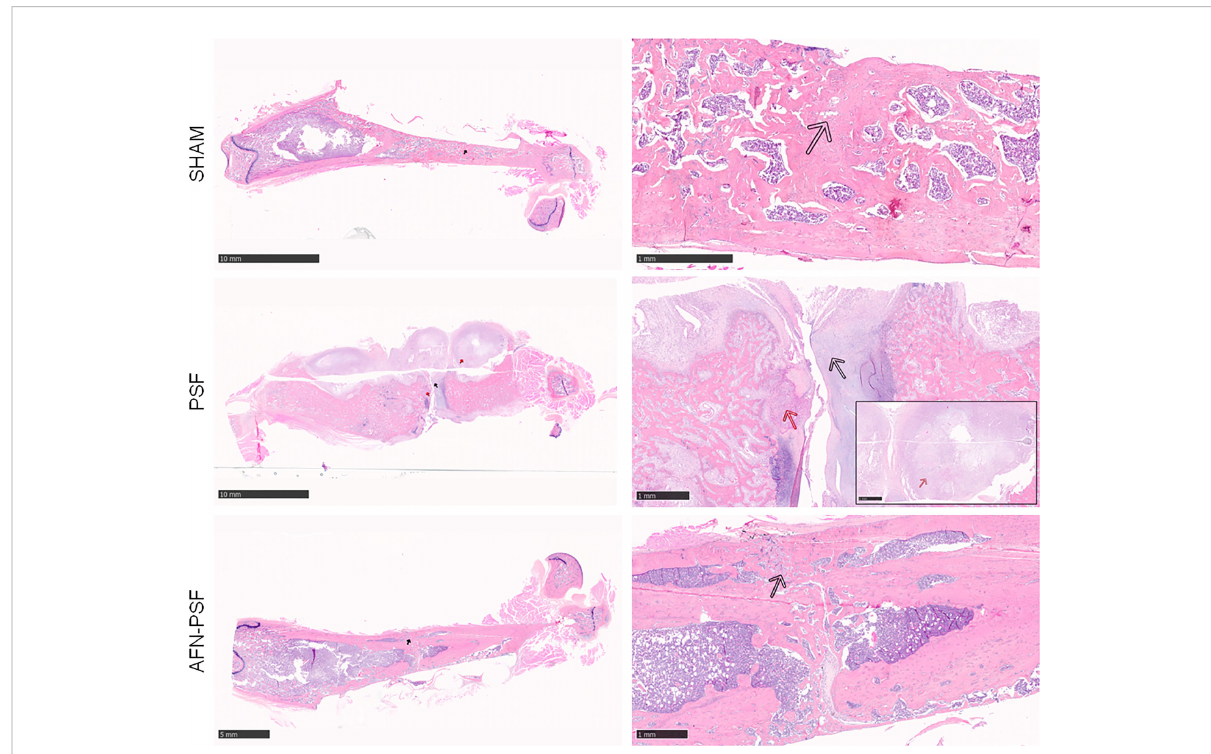
FIGURE 5 Qualitative H&E histological panel. The representative panel shows the complete fracture healing with new bone formation in a remodeling phase (black arrow) of the SHAM and AFN-PSF groups. The PSF group showed a complete disorganization of the bone structure and abundant fi brovascular tissue typical of nonunion (black arrow), as well as the presence of chronic abscesses and necrotic tissue (red arrows). Scale bars at 10 mm (left side) and 1 mm (right